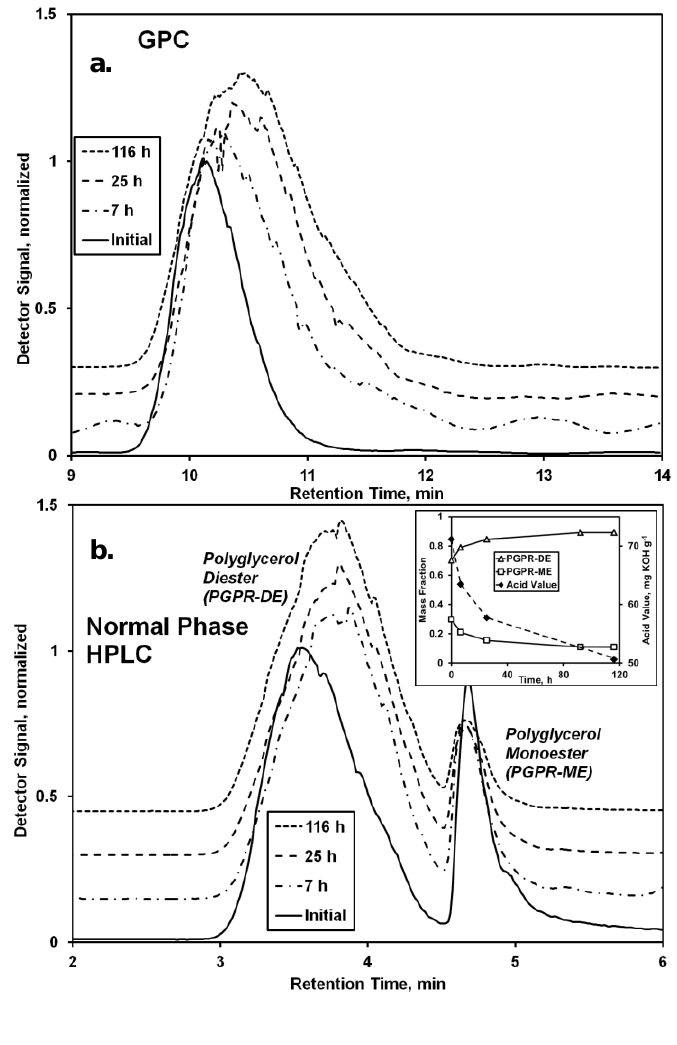
Figure 2. Analysis of the CAL-catalyzed modification of polyglycerol polyricinoleate ( PGPR ) with 10-undecenoic acid. Chromatograms from ( a ) GPC and ( b ) normal